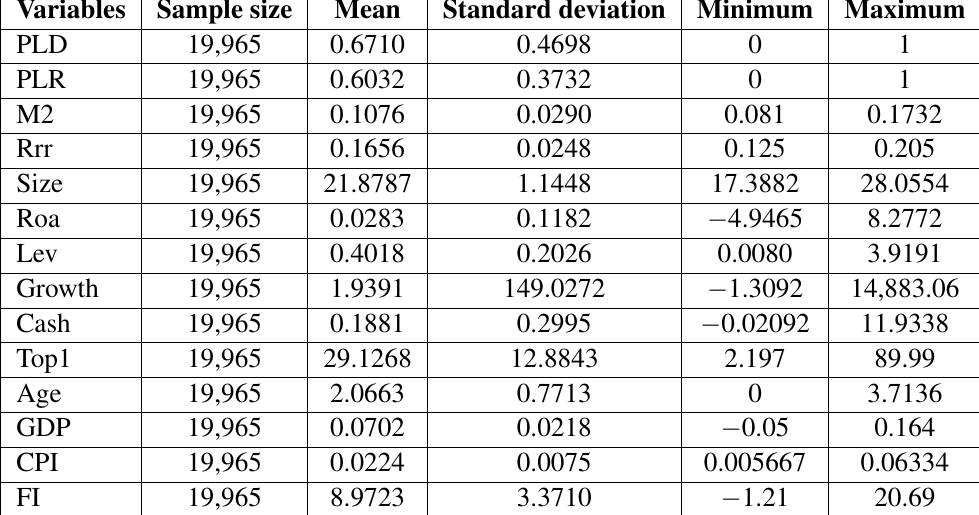
Table 3 Main variable descriptions.